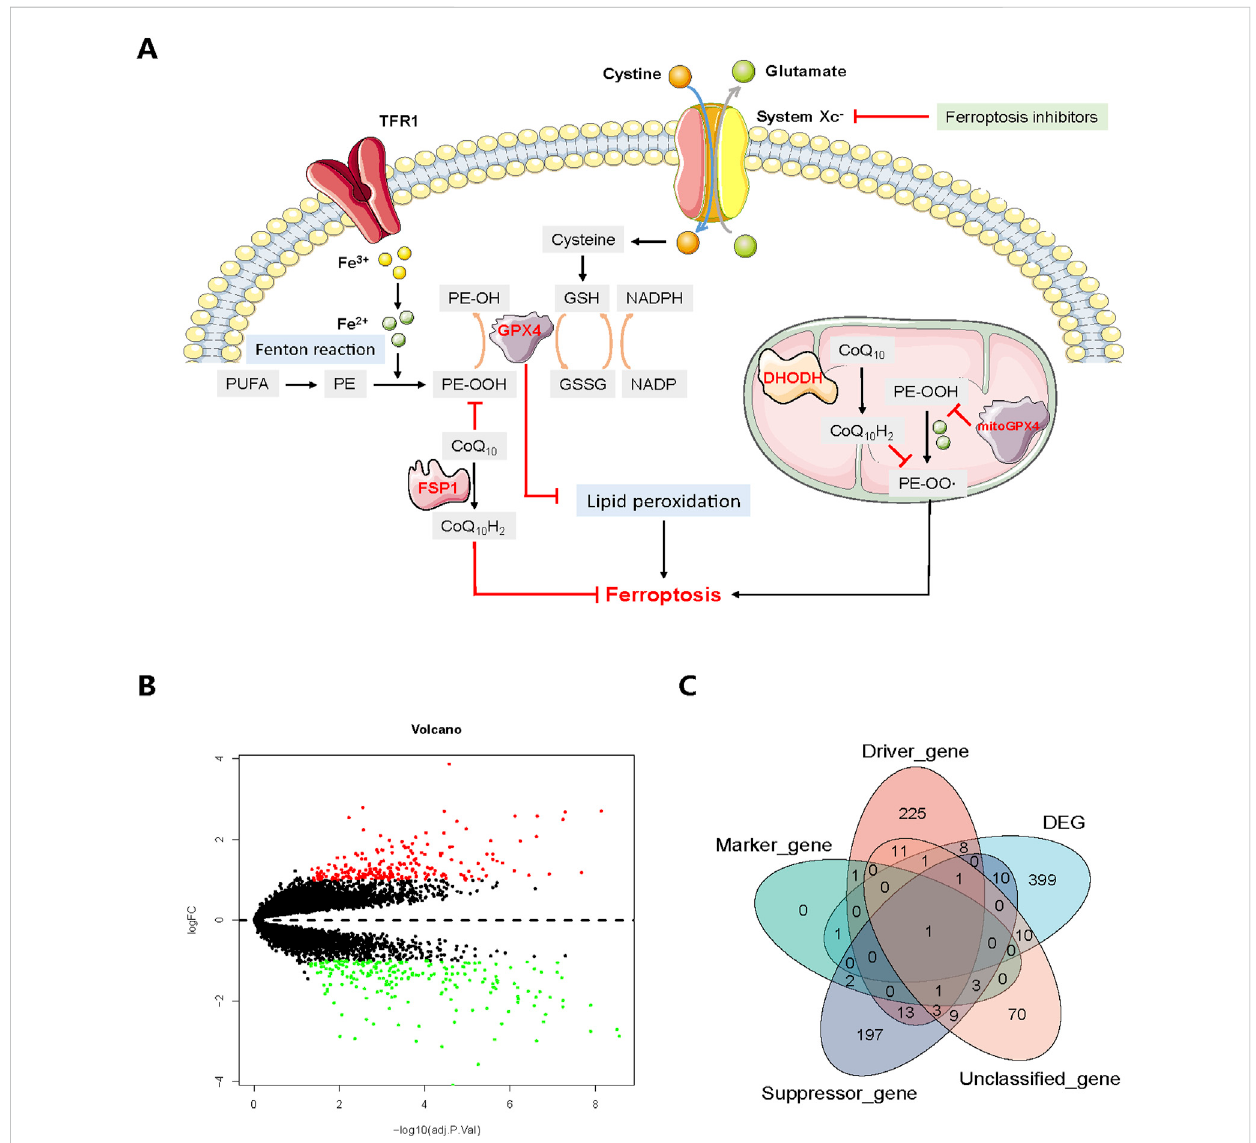
FIGURE 1 (A) Core mechanisms of ferroptosis. System Xc − -mediated cystine uptake, subsequent GSH production and GPX4 activation play a central role in protecting cells from ferroptosis. Alternatively, FSP1 inhibits ferroptosis by catalyzing the production of CoQ 10 H 2 from CoQ 10 . Moreover, PUFA- phospholipids (PL-PUFAs) could be derived from PUFAs, which later produce PL-PUFA-OOH through Fenton reaction. TFR1 transports iron ion, which then participates the Fenton reaction in the form of ferrous ion. In the mitochondria, DHODH facilitates the generation of CoQ 10 H 2 to suppress ferroptosis whereas the mitochondria GPX4 could restrain PE-OOH from producing PE-OO · , thus further arresting ferroptosis process. The red marks and black arrows indicate ferroptosis promotion and inhibition. (B) Volcano plot of DEGs between normal and osteoarthritis patients. Upregulated DEGs are indicated by red dots while downregulated DEGs are indicated by green. (C) Venn diagram showing the overlap between DEGs and ferroptosis- related genes. GSH, glutathione; GSSG, oxidized glutathione; NADPH, reduced nicotinamide adenine dinucleotide (phosphate); NADP, oxidized nicotinamide adenine dinucleotide (phosphate); PE,